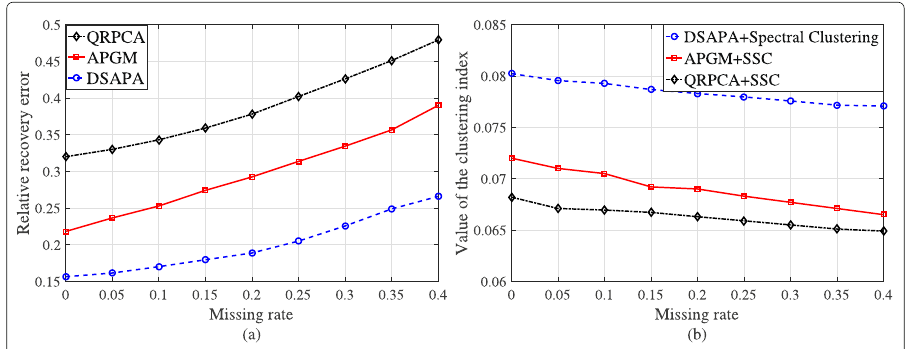
Fig. 8 Relative recovery error and clustering accuracy when the missing rate changes ( s / mn = 5%)